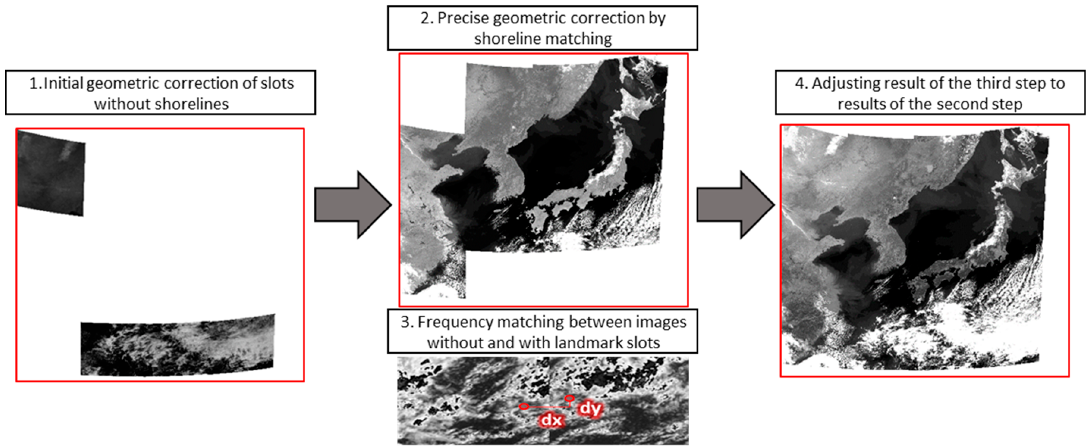
Figure 8. Process of mosaicking under our method.